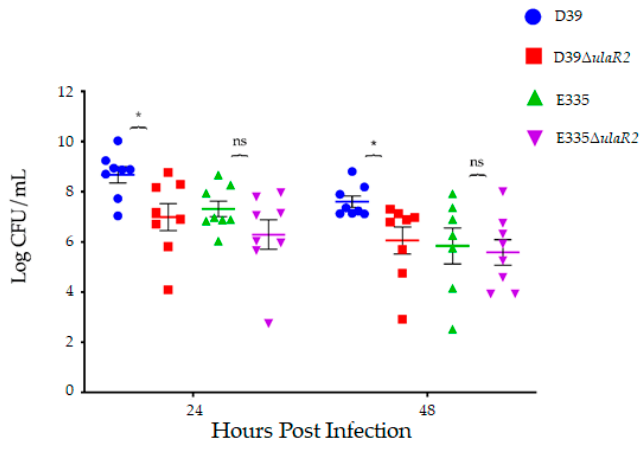
Figure 3. Bacterial recovery from rabbit vitreous humor infected with each strain 24 and 48 h after infection. Asterisks indicate the following: * p < 0.05. “ns” indicates “not significant.”